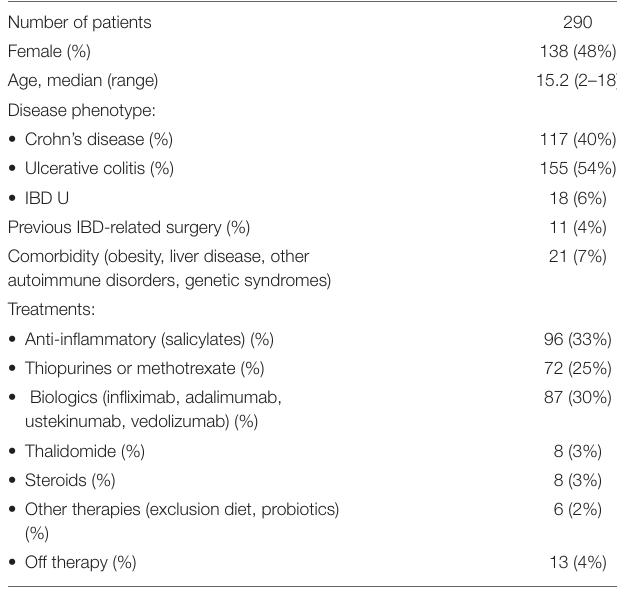
TABLE 1 | Demographic and clinical features of the study population during the